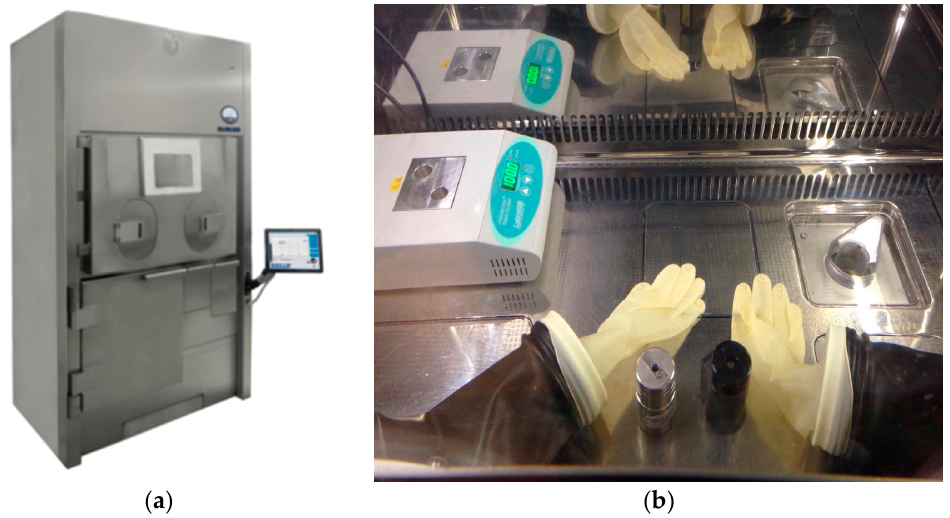
Figure 1. Murphil-Tc (MecMurphil): the isolator ( a ) and the work area inside the isolator ( b ).